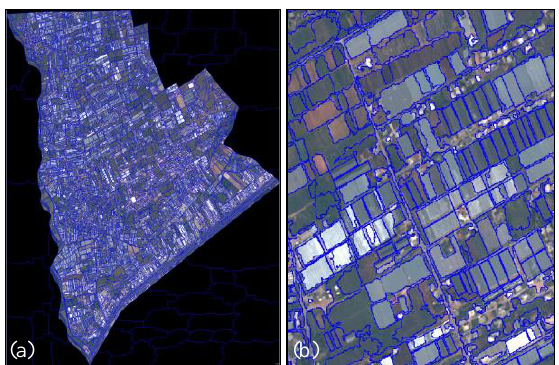
Figure 5. (a) The result of segmentation belonging to the study area. (b) The result of segmentation belonging to a